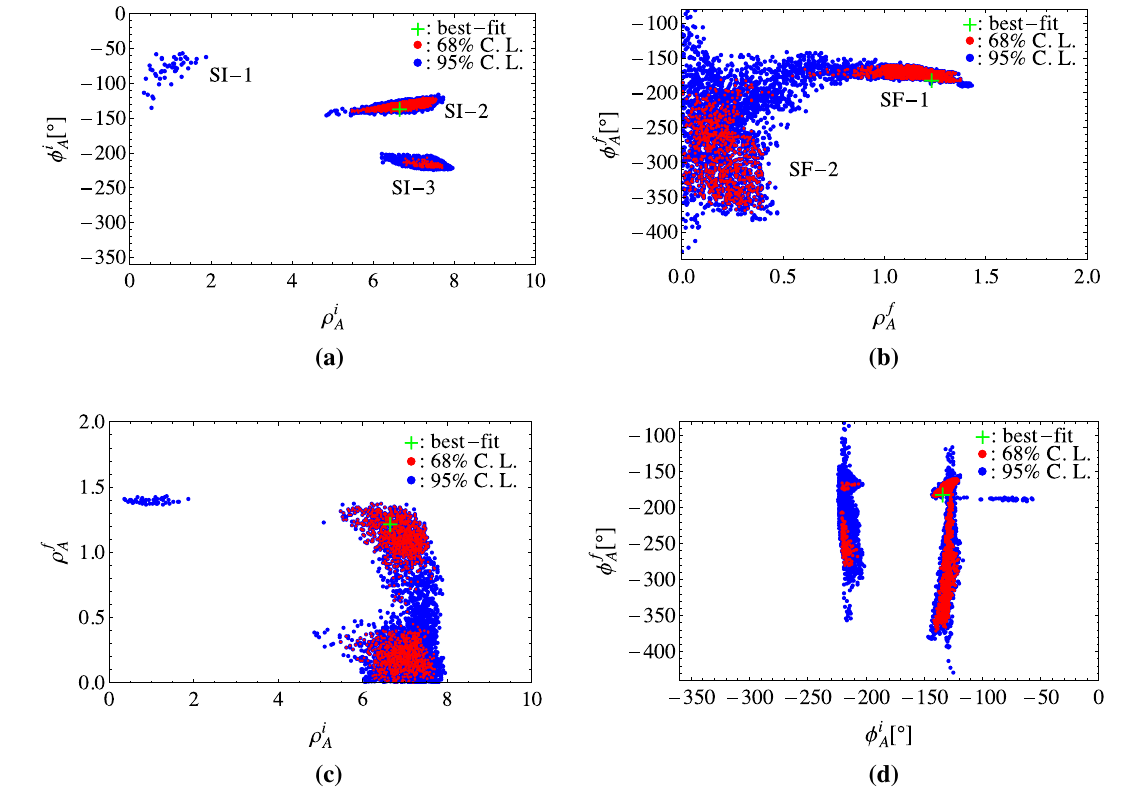
, f ,φ i , f ) at 68% C.L. and 95% C.L. under the combined constraints from ¯ B A A / n = 11 . 2 / dof min